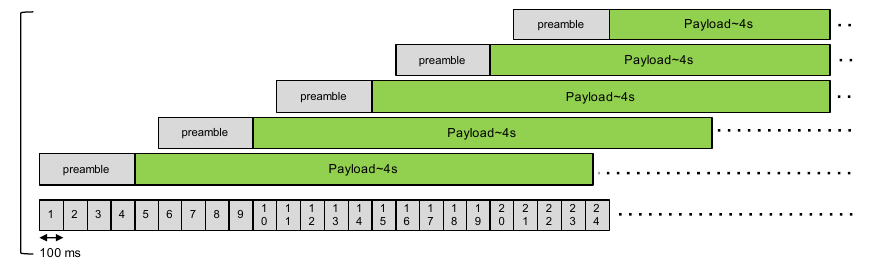
Figure 9. Second CE experimentation, case